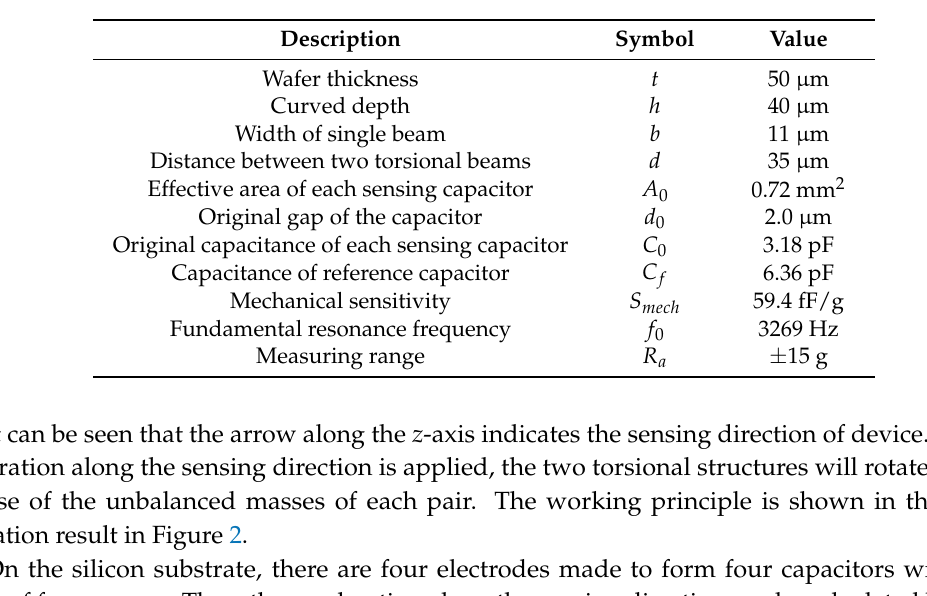
Figure 1. Design model of the accelerometer: ( a ) Overview of the device; ( b ) Back view of the device; ( c ) The cross section of the silicon structure. Table 1. Geometrical parameters of the novel accelerometer.